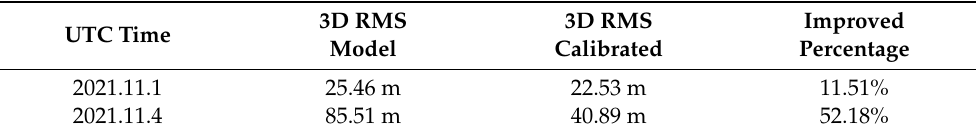
Table 2. Comparison of the derived density and model density of 24 h orbit propagation of the 3DRMS without and with geomagnetic